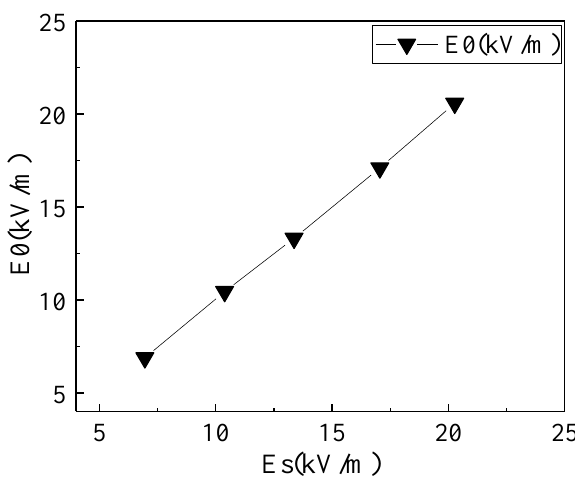
Figure 10. Comparison of the measured values E 0 and the calculated values Es .